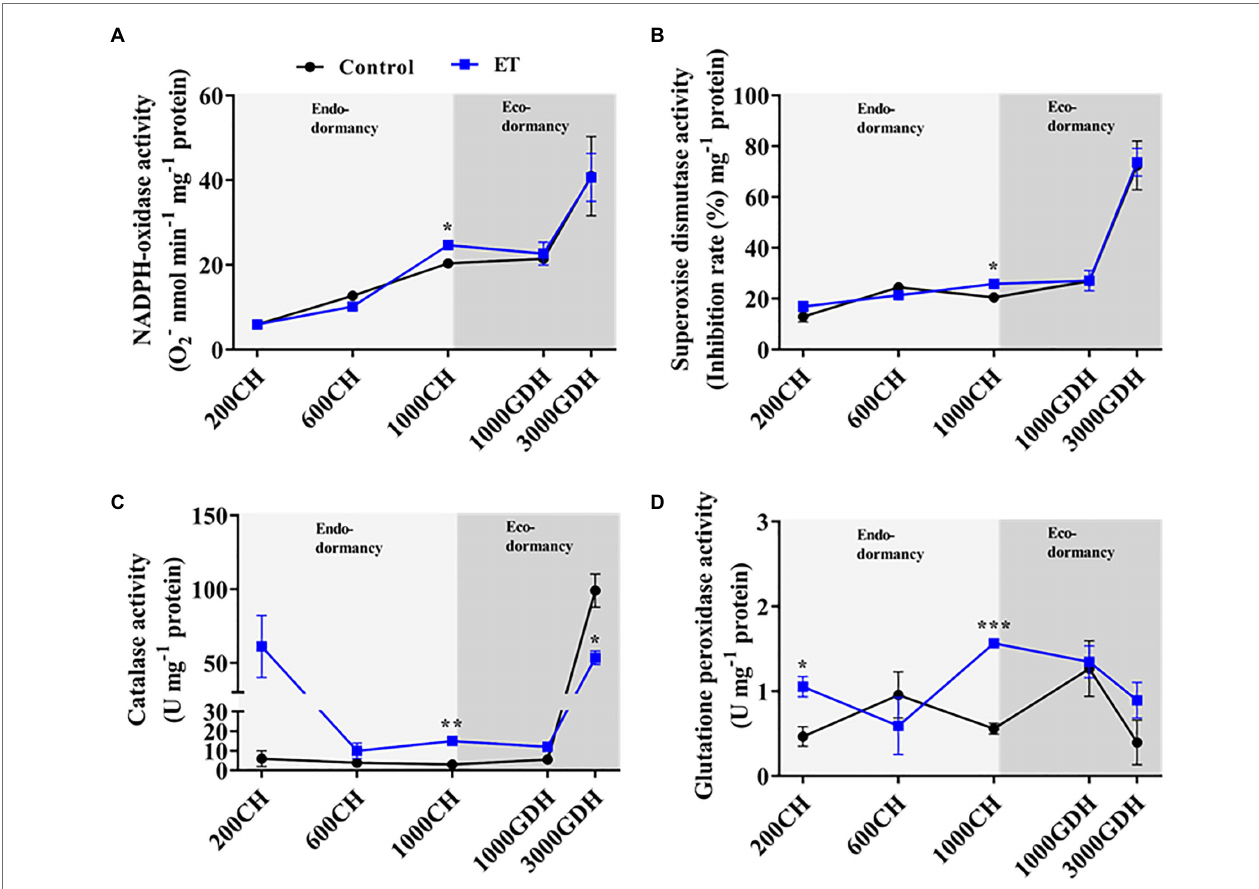
FIGURE 4 | Changes in the activity of the antioxidative enzymes in peach “Red haven” floral buds during the dormancy in responses to ethephon (ET) treatment. NADPH-oxidase activity (A) , superoxide dismutase activity (B) , catalase activity (C) , and glutathione peroxidase activity (D) . Data represent the mean ± SEM for n = 3. Asterisks indicate significant differences between the control and ET-treated plant buds at different chilling hours (CH) and GDH; ∗ p < 0.05; ∗∗ p < 0.01; and ∗∗∗ p <